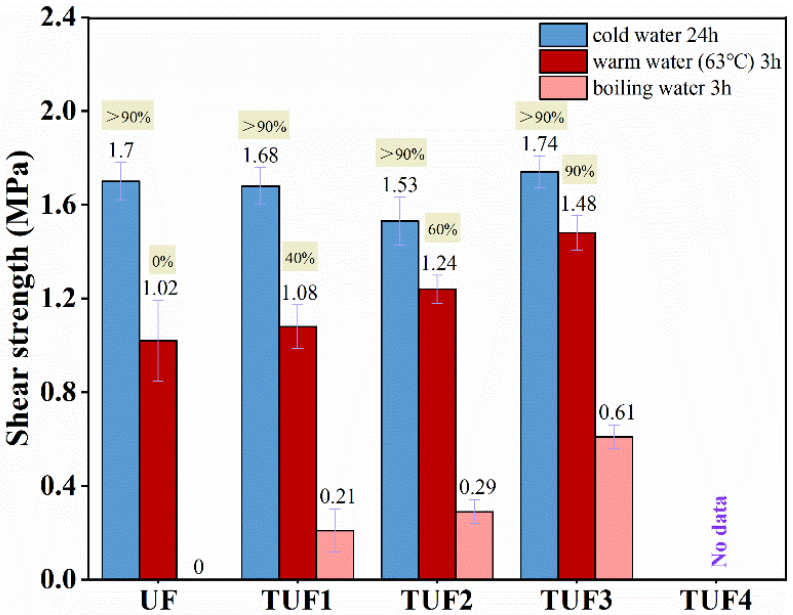
Figure 6. Shear strength values of plywood specimens bonded with resins prepared at different reaction temperatures (the highlight indicates the wood failure